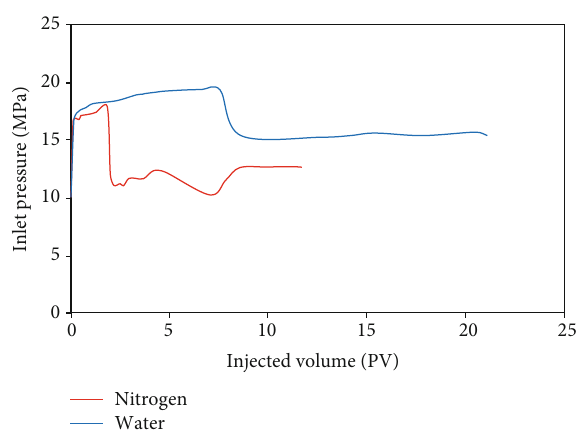
Figure 4: Curve of the relationship between injection volume and pressure of core inlet in di ff erent